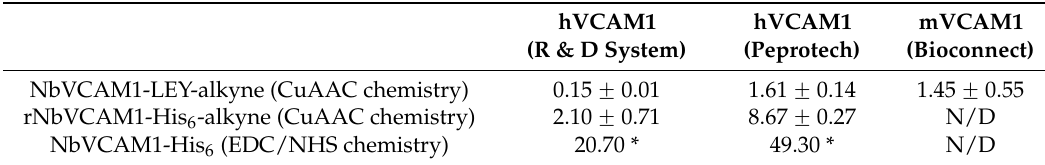
Table 2. The dissociation constant (K D in nM ˘ standard error) for the binding of the human and mouse recombinant VCAM1 antigens to the nanobody-conjugated flow cells prepared by the different coupling